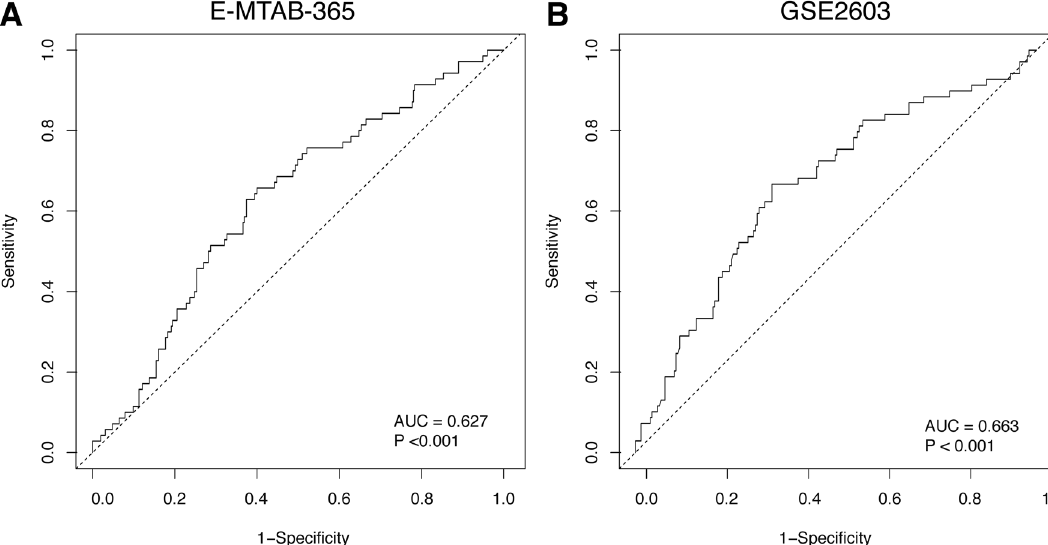
Figure 3. ROC curve analysis to test the validity of TOR1B gene expression in discriminating bone metastasis and non-bone metastasis status in breast cancer patients by ROC curve analysis for predicting bone metastasis in the E-MTAB-356 ( A ) and GSE2034 ( B ) datasets.